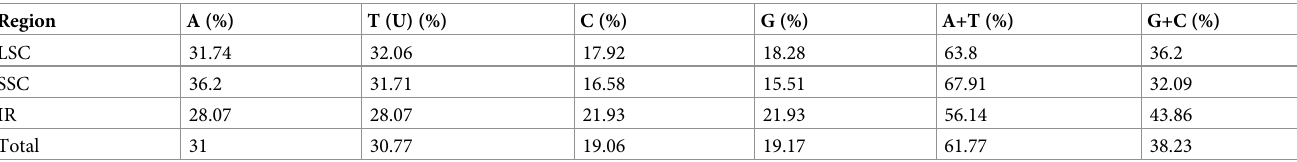
Table 1. Base composition in a single strand of the H . brevisubulatum cp genome.